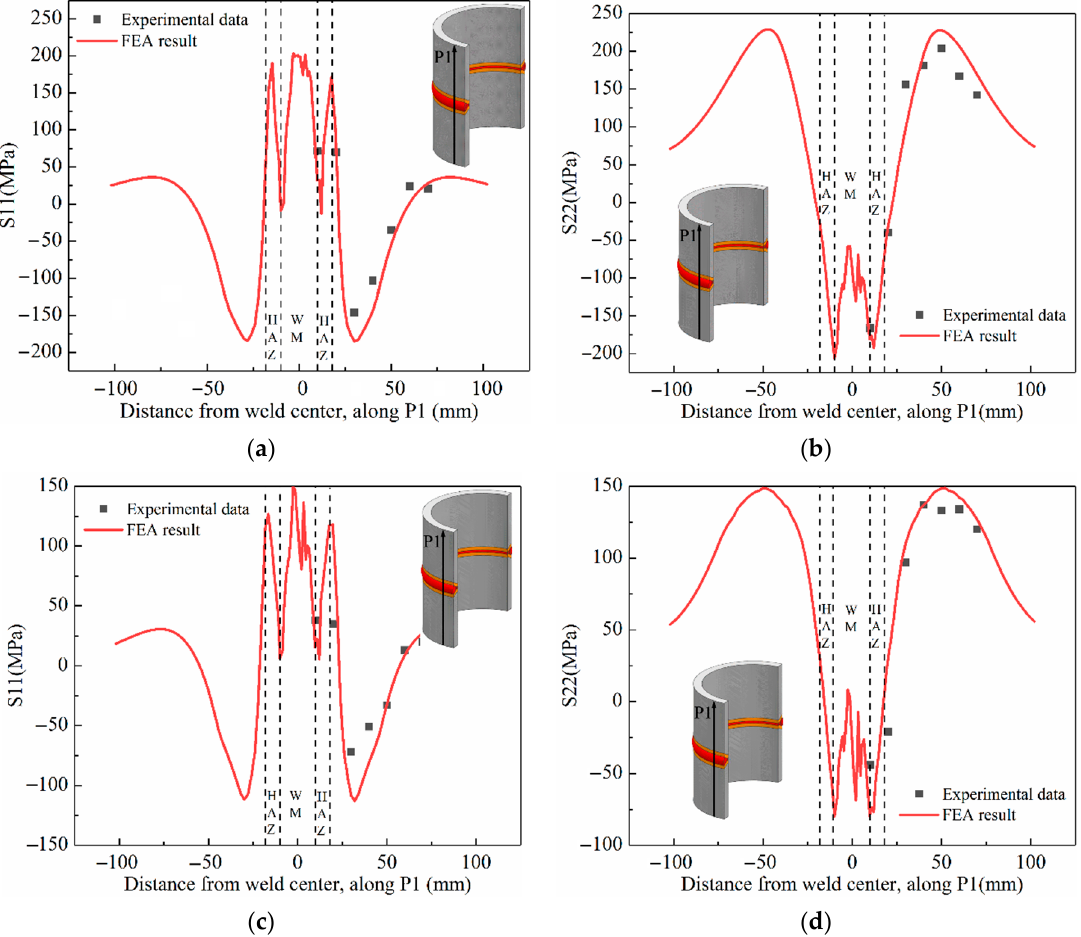
Figure 10. Comparison of the residual stress distribution along P1 path between experimental data and finite element analysis (FEA) result under different heat treatment conditions, S11 ( a ) and S22 ( b ) is the residual stress after dehydrogenation heat treatment (DHT); S11 ( c ) and S22 ( d ) is the residual stress after tempering heat treatment.